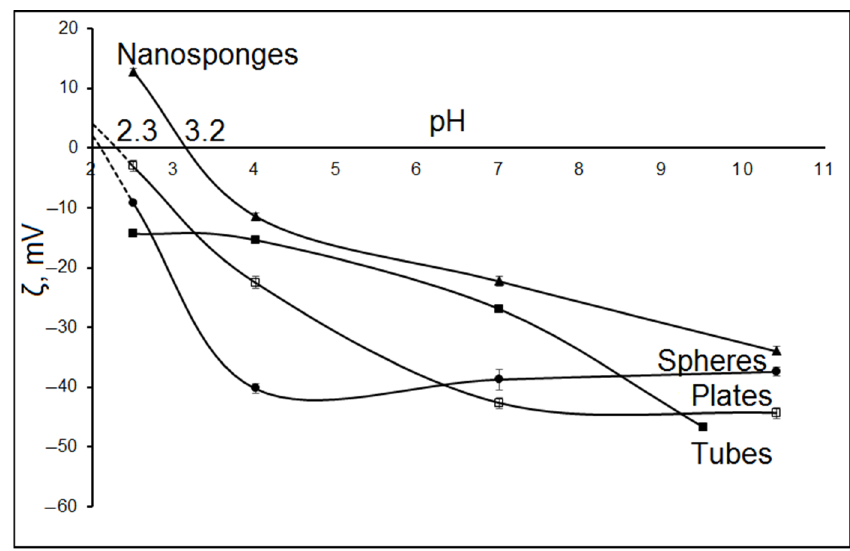
Figure 5. Dependence of the zeta potential of the sample surface on pH.